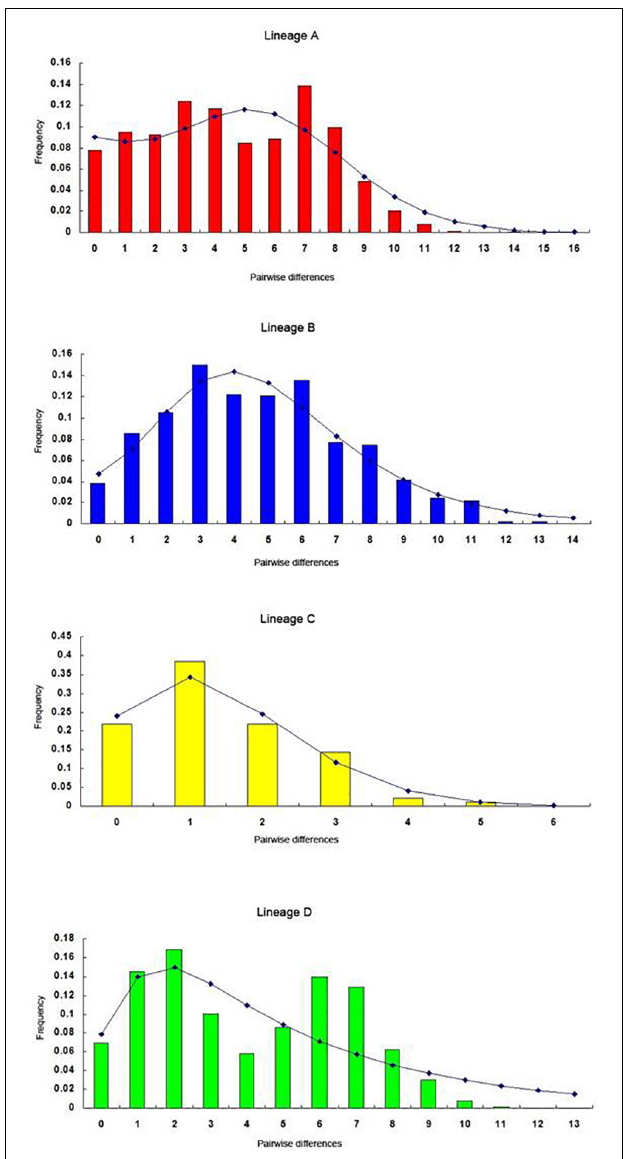
FIGURE 6 | The observed pairwise differences (bars), and the expected mismatch distributions under the sudden expansion model (solid line) for the mtDNA D-loop haplotypes in lineages A, B, C, and D.